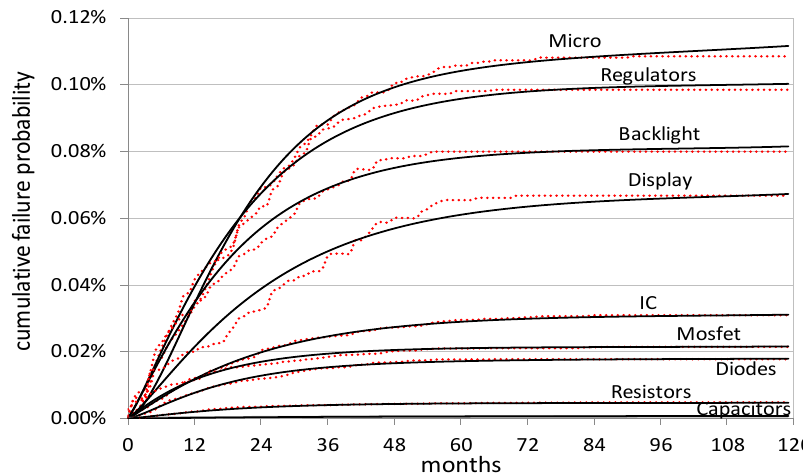
Figure 9. Cumulative failure probability of different components: experimental data (dotted lines) and model (continuous lines). Table 1. Table of coefficients of the failure model.